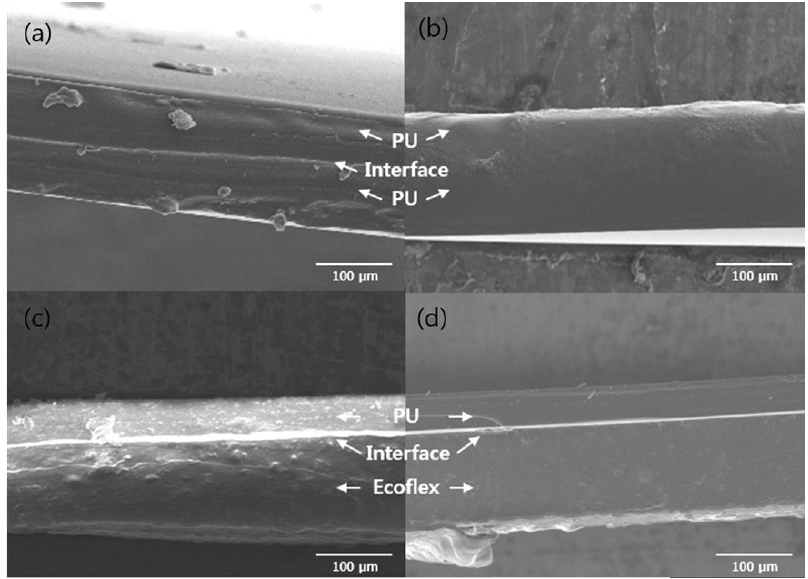
Figure 3. ( a ) Polyurethane-polyurethane (PU–PU) cross-sectional scanning electron microscope (SEM) image cut using the general cutting method. ( b ) PU–PU cross-sectional SEM image cut using the OLE method; ( c ) PU–Ecoflex cross-sectional SEM image cut using the general cutting method; and ( d ) PU–Ecoflex cross-sectional SEM image cut using the OLE method.